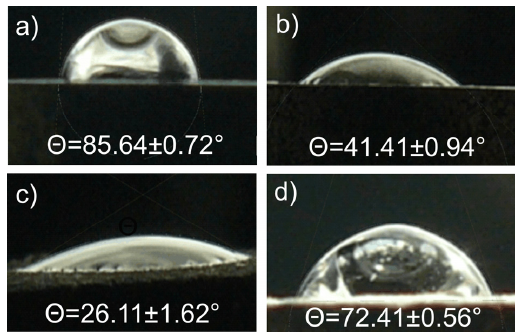
Figure 9. Contact angles of glycerol on the nanostructured bulk Ti23Mo alloy ( a ) and Ti23Mo